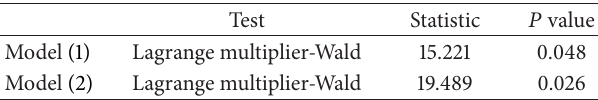
Table 4: Linearity tests.